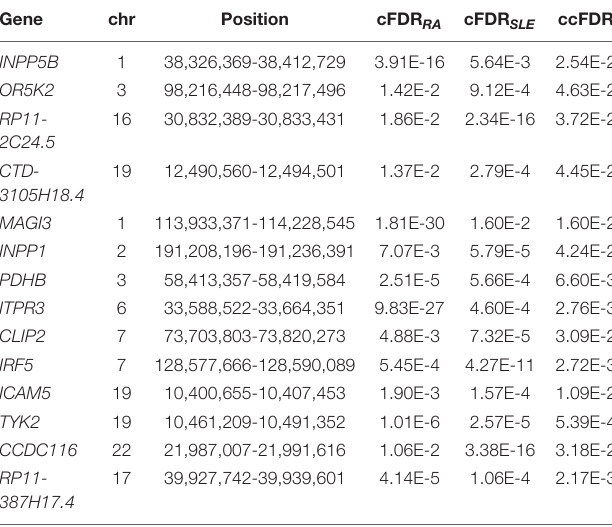
TABLE 2 | Enriched pathways for potential pleiotropic genes of RA and SLE.